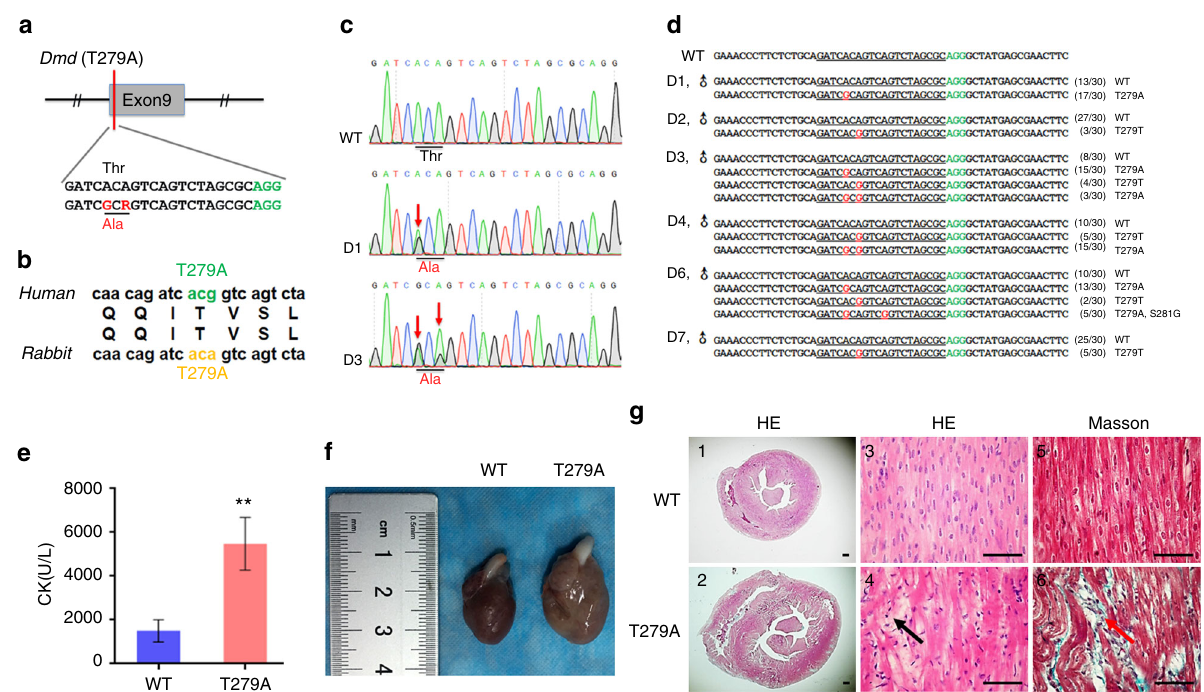
Fig. 6 Generation of an XLCM rabbit model using the ABE7.10 system. a The target sequence within the Dmd locus. Target sequence (black), PAM region (green), and substituted nucleotide (red, R = A/G). b Diagrammatic representation of mutations associated with XLCM in humans and rabbits. c Representative Sanger sequencing chromatograms of DNA from WT and mutant rabbits (D1 and D3). Red arrow indicates the substituted nucleotide. The relevant codon identities at the target site are presented beneath the DNA sequence. WT wild-type. d PCR amplicons of the target site from genomic DNA of mutant rabbits were subcloned into the pGM-T vector and sequenced. The number of clones for each sequence pattern is indicated. Target sequence (underlined), PAM region (green), and substituted nucleotide (red). e Serum CK levels of WT and T279A mutant rabbits ( n = 4). ** p < 0.01, Student ’ s t test. f Representative gross morphology of whole hearts from WT and T279A mutant rabbits at 1 month of age. g Transverse cross sections at mid-ventricle level of whole hearts. Corresponding H&E-stained and Masson ’ s trichrome-stained longitudinal sections of cardiac muscle showed myocyte disarray (black arrow) and fi brosis (red arrow). Scale bar in 1 and 2 represent 0.4 mm and scale bar in 3, 4, 5, and 6 represent 50 μ